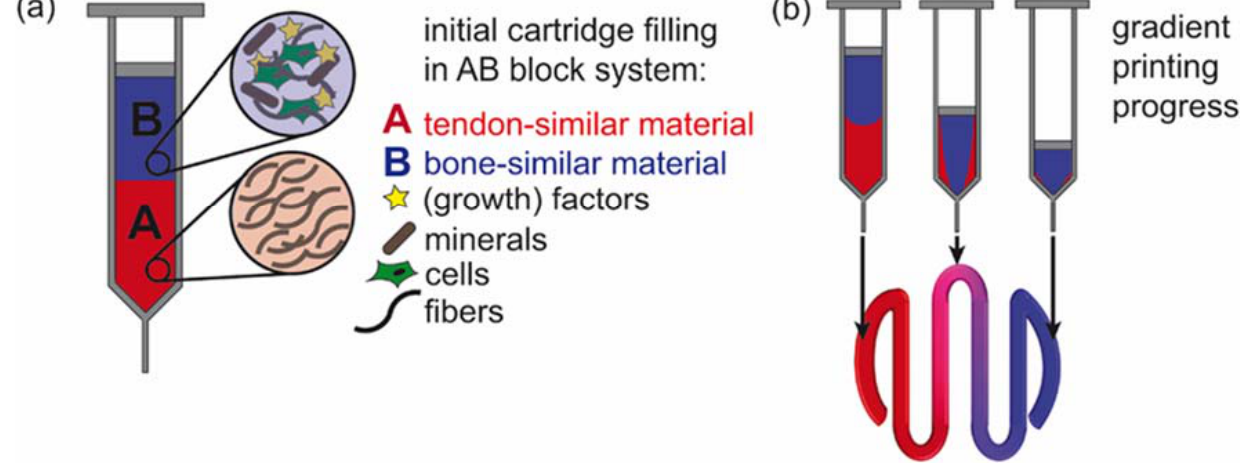
Figure 6. Concept of gradient printing from one printer cartridge of materials relevant for biofab- rication of tissues at the tendon/bone interface. ( a ) AB block filling of a tendon-similar material (A, red) and a bone-similar material (B, blue) with tissue-specific features. ( b ) Material extrusion during printing and gradient scaffold generation.